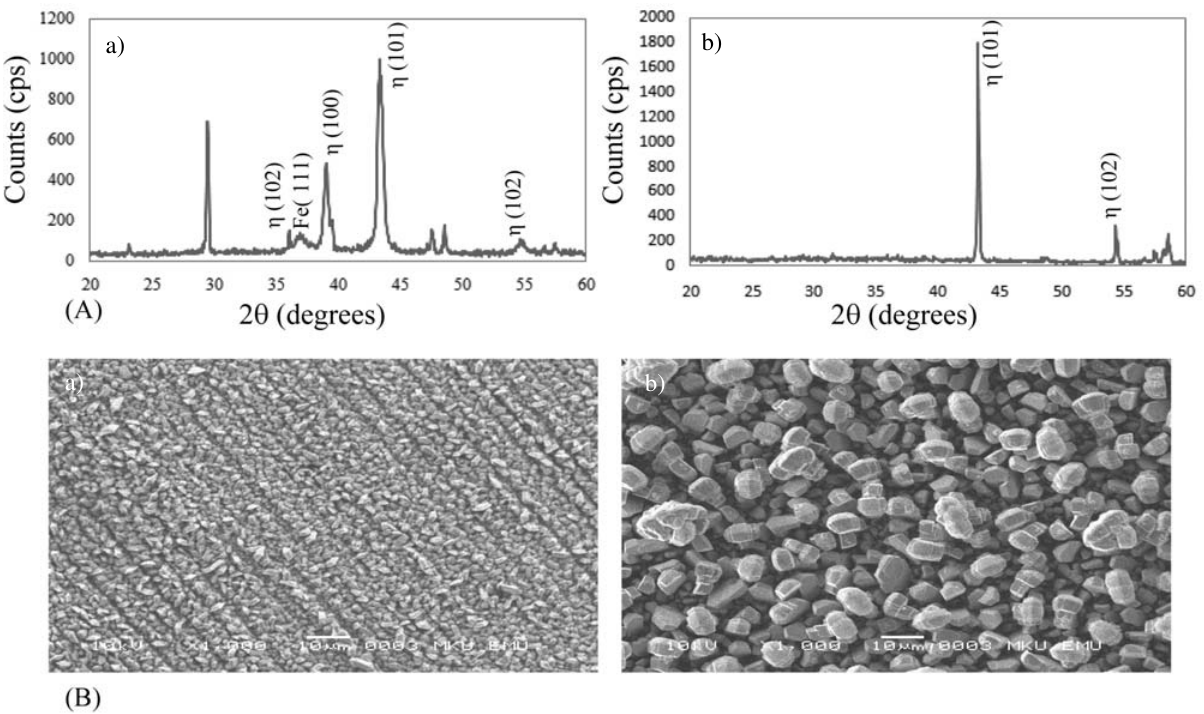
Fig. 2. X-ray diffractograms (A) and SEM images (magnification: 1000) (B) of ZnFe (a) and ZnFeCo (b) platings obtained on car- bon steel applying constant current of 3